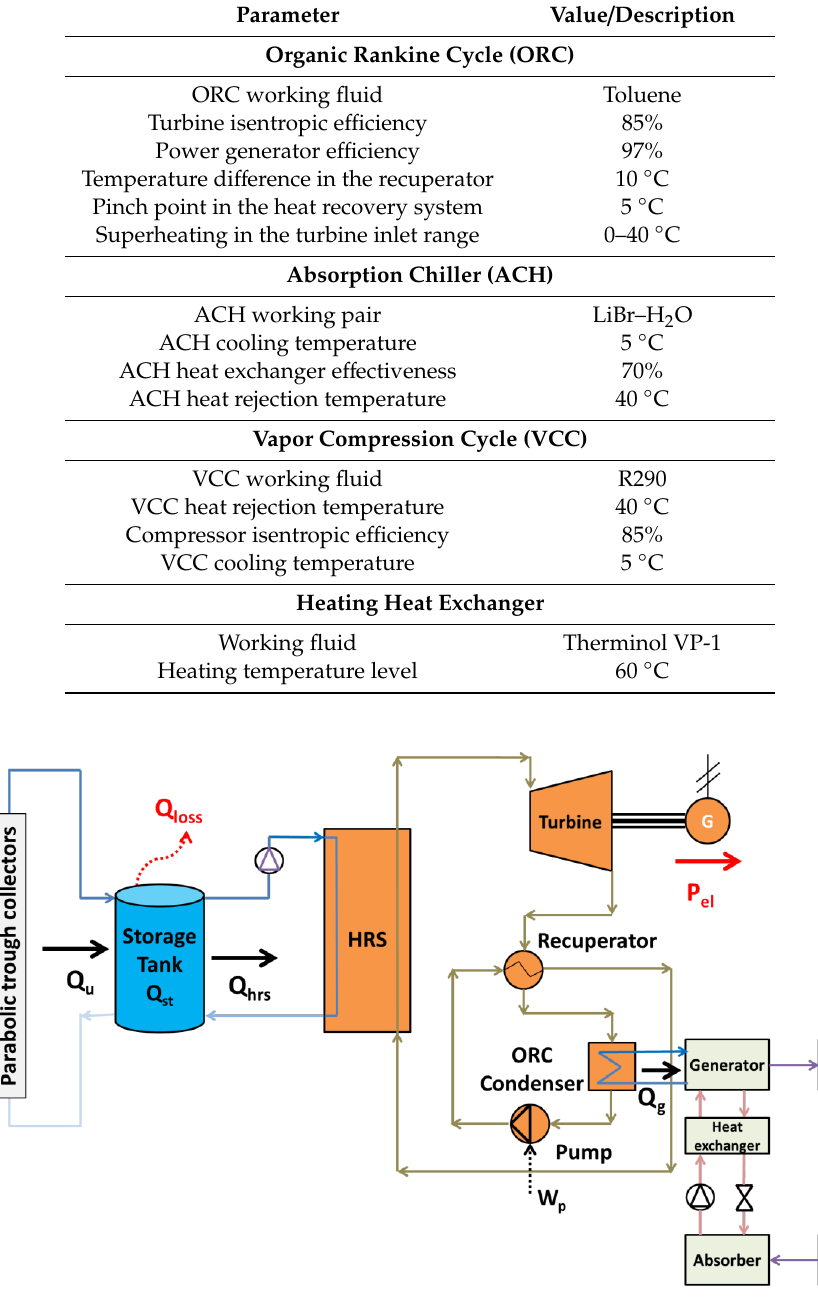
Table 2. Main data of the examined devices in the trigeneration systems.